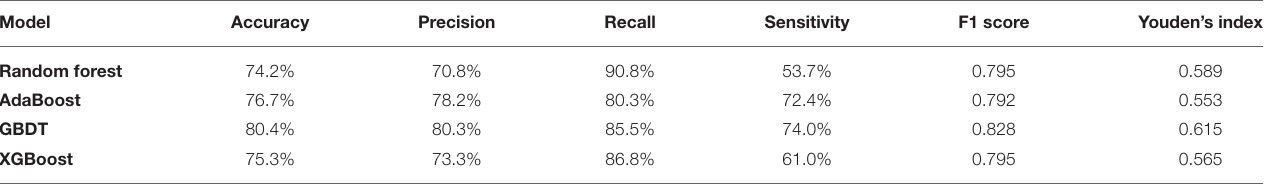
TABLE 3 | Performance of random forest, AdaBoost, GBDT, and XGBoost models in screening COVID-19. Model